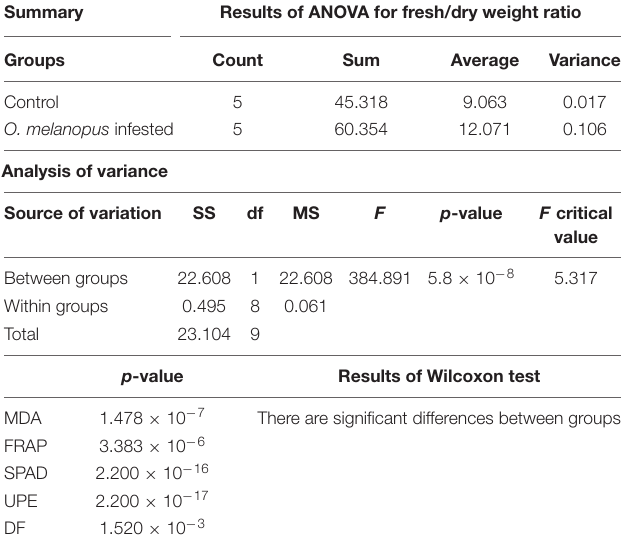
TABLE 1 | Statistical analysis of the examined stress parameters in damaged wheat caused by O. melanopus : ANOVA analysis of fresh/dry weight ratio